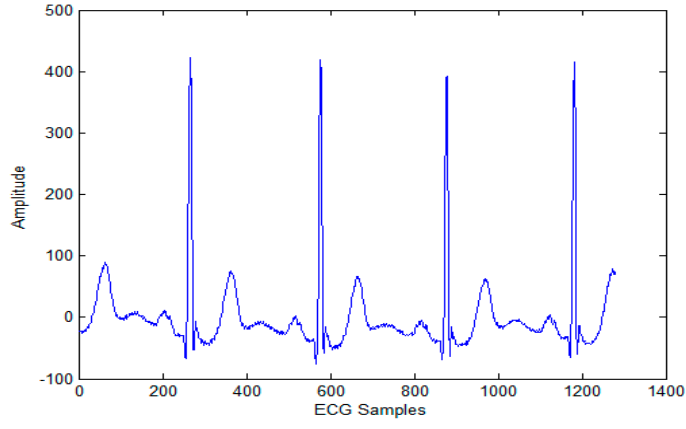
Figure 1. Original 1-D electrocardiogram.